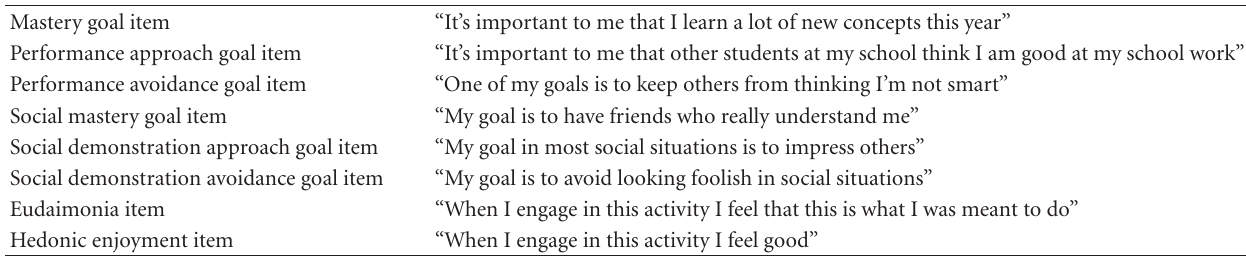
Table 1: Example items for each subscale.